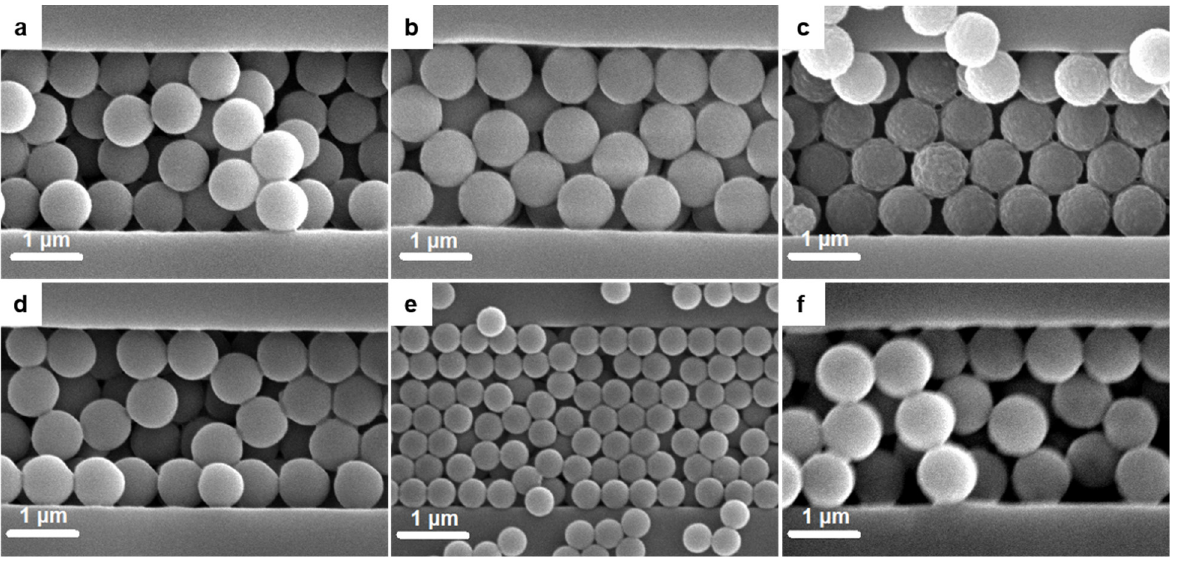
Figure 3. SEM images of spheres of different size stained with various dyes and assembled into 2.5 µ m wide and 2 µ m deep periodic grooves: ( a ) amino pink (AP), ( b ) amino red (AR), ( c ) yellow/Y, ( d ) jade green/G, ( e ) pink/P, and ( f ) Nile red (R1).